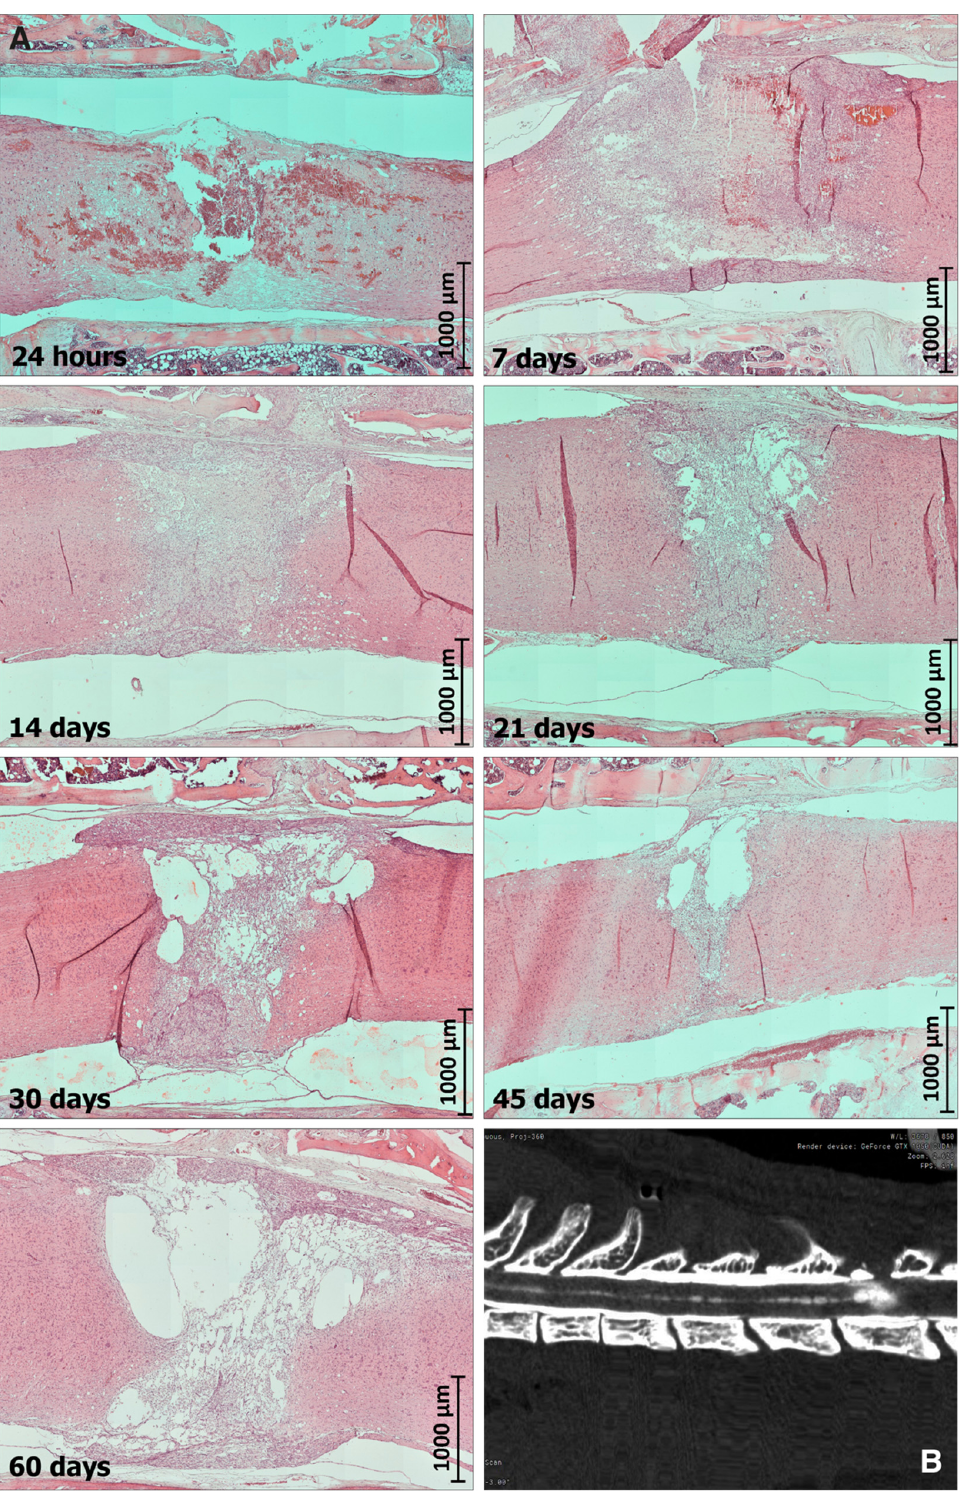
Figure 2. Dynamics of the glial scar formation after spinal cord cryoinjury in SD rats. ( A ) Hematoxylin and eosin staining of a sagittal section of the spinal cord in the vertebral column on day 0, 7, 14, 21, 30 and 60 after the cryoinjury. Scale bars are indicated. ( B ) Contrast visualization of the posttraumatic cyst in thoracic spine.